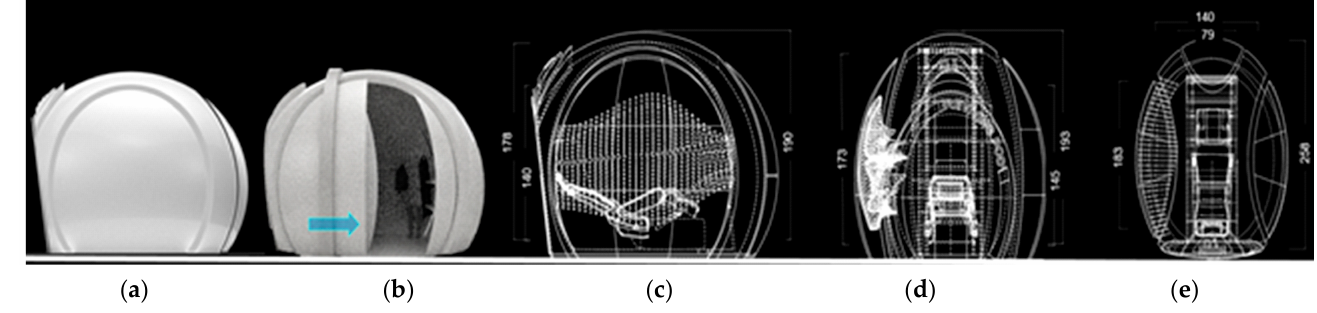
Figure 9. ( a ) Rendered side views illustrating the pod’s form; ( b ) the door mechanism as shown by arrow illustration; ( c ) cross-section; ( d ) elevation; ( e ) plan with dimensions in centimeters (designed by the authors).